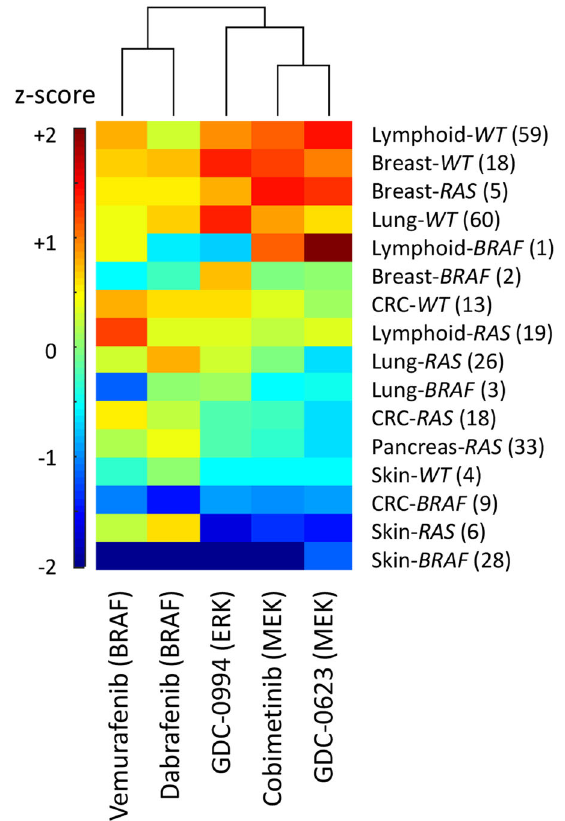
Fig. 9 Relative sensitivity ( z -scored mean viability) to BRAF, MEK, and ERK inhibition by indication. Cancer cell lines were separated by tissue type and mutational status (RAS = KRAS, HRAS or NRAS mutant, RAF = BRAF-mutant, WT = RAS/RAF wild type), and median values computed for